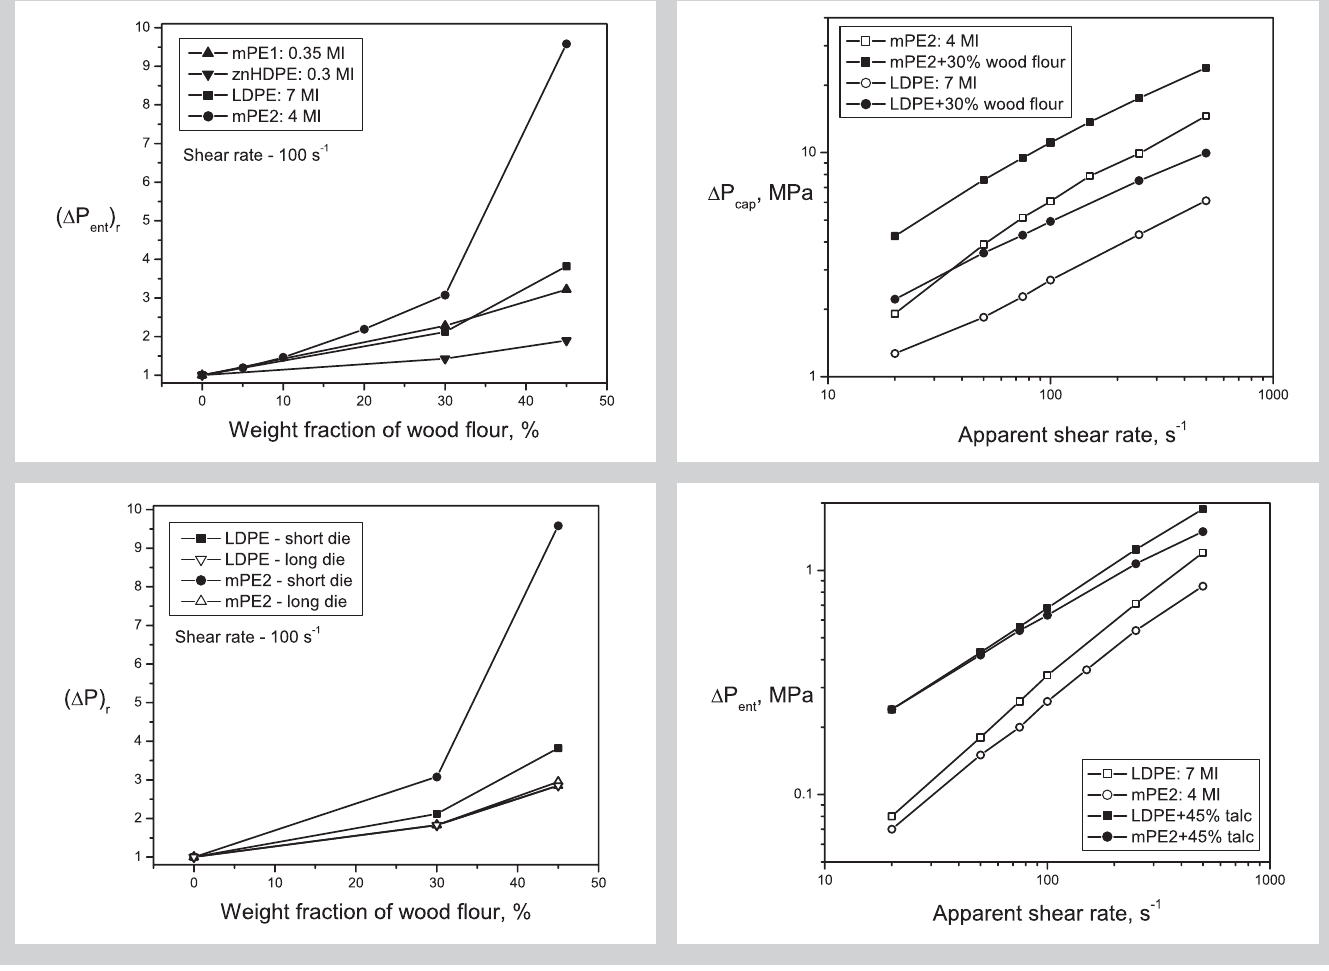
Figure 6 (left above): Relative entrance pressure loss of PE/wood flour com- posites. Figure 7 (right above): Pressure drop in the long capillary as a function of the apparent shear rate of the high melt index polyethyl- ene/wood flour composites. Figure 8 (left below): Comparison of the relative pressure drop in the short and long capillary dies of PE/wood flour composites. Figure 9 (right below): Entrance pressure loss as a function of the apparent shear rate of the high melt index polyethylene/talc